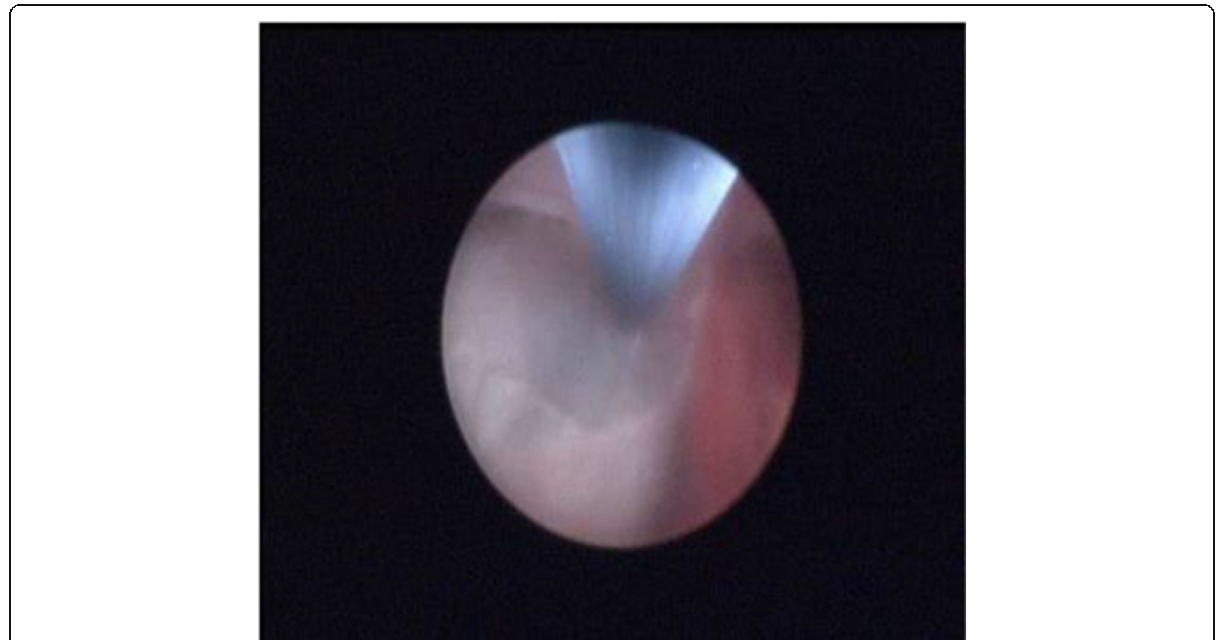
Fig. 1 Endoscopic view showing opening the dome of the cyst